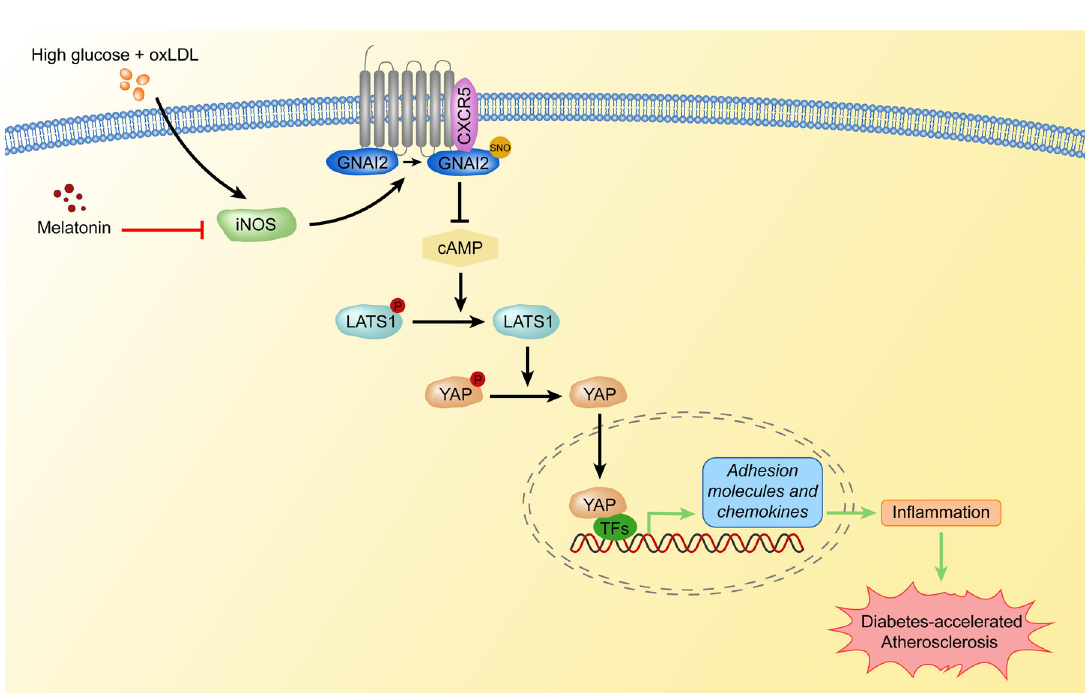
Fig. 8 Graphic model of SNO-GNAI2-induced diabetes-accelerated atherosclerosis. During diabetes-accelerated atherosclerosis, high glucose, and oxLDL increases S-nitrosylation of GNAI2 in endothelial cells, which enhances coupling with CXCR5 and reduces cAMP level. The reduction in cAMP dephosphorylates LATS1 and YAP, promotes nuclear translocation of YAP and promotes transcription of adhesion molecules and chemokines, which enhances endothelial in fl ammation. Melatonin restores phosphorylation of LAST1 and YAP through reducing iNOS-induced SNO-GNAI2 and alleviates endothelial in fl ammation, which improves diabetes-accelerated atherosclerosis. oxLDL oxidized low-density lipoprotein, GNAI2 guanine nucleotide-binding protein G(i) subunit alpha-2, CXCR5 C-X-C chemokine receptor type 5, cAMP cyclic adenosine monophosphate, LATS1 large tumor suppressor kinase 1, YAP Yes-associated protein, iNOS inducible nitric oxide